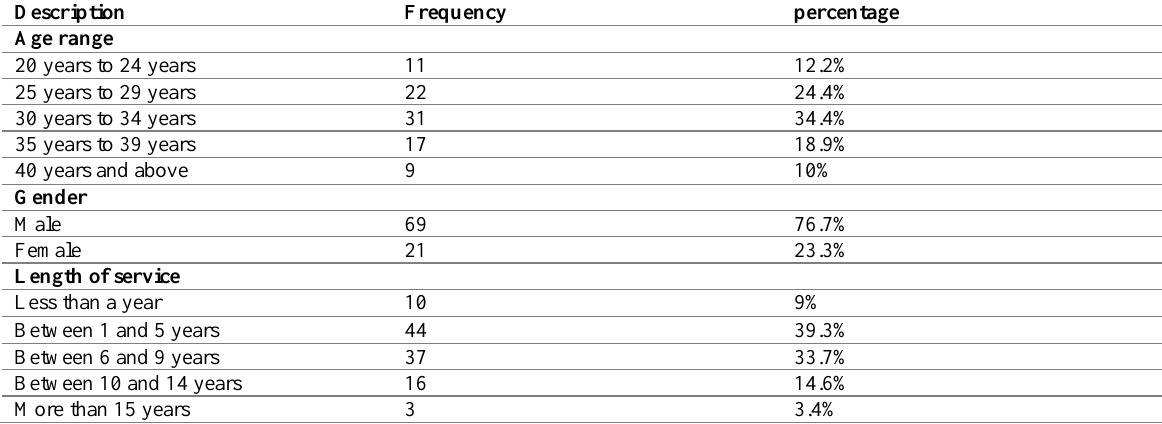
Table 1: Analysis of demographic data of the respondents (n=90)